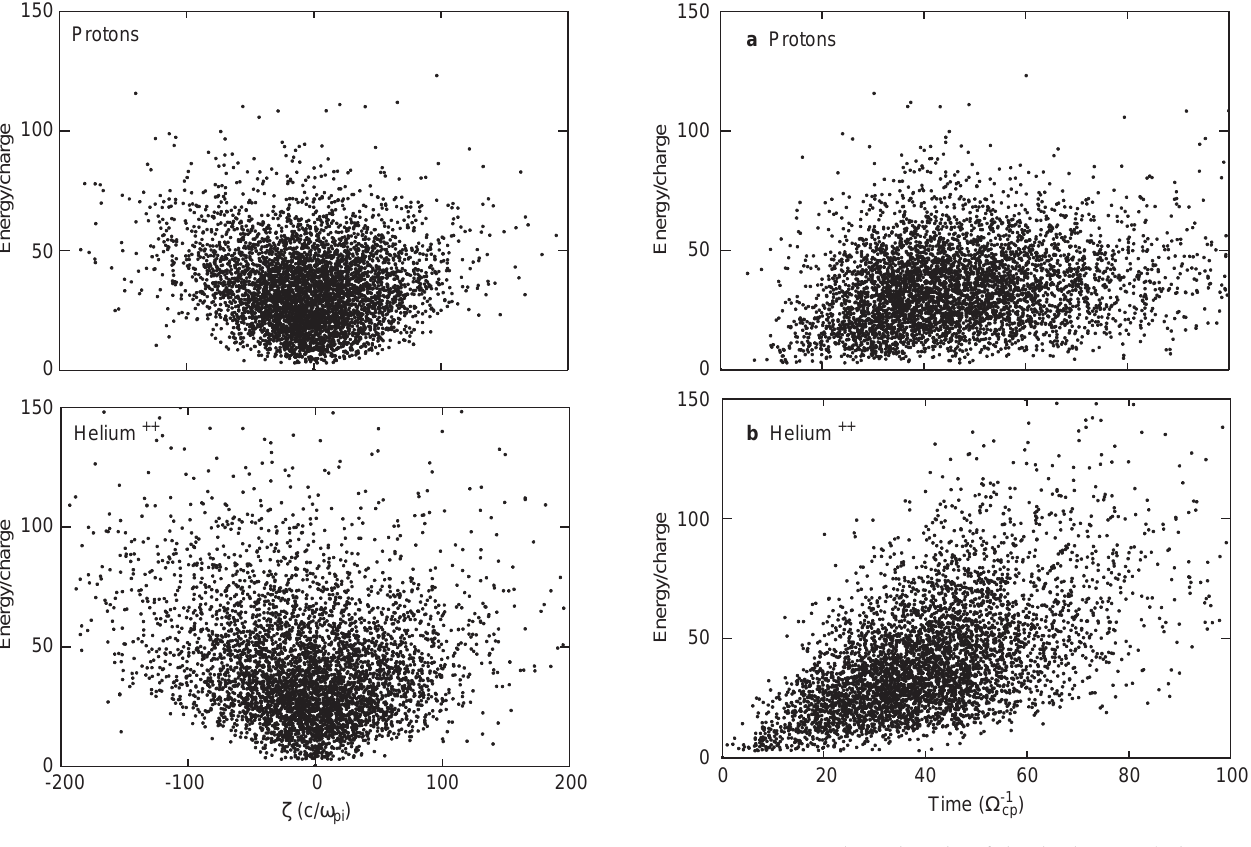
Fig. 9. Energy per charge in units of the shock ram velocity E p of upstream ions versus drift length f in the de Ho(cid:128)mann-Teller frame. a protons; b alpha particles